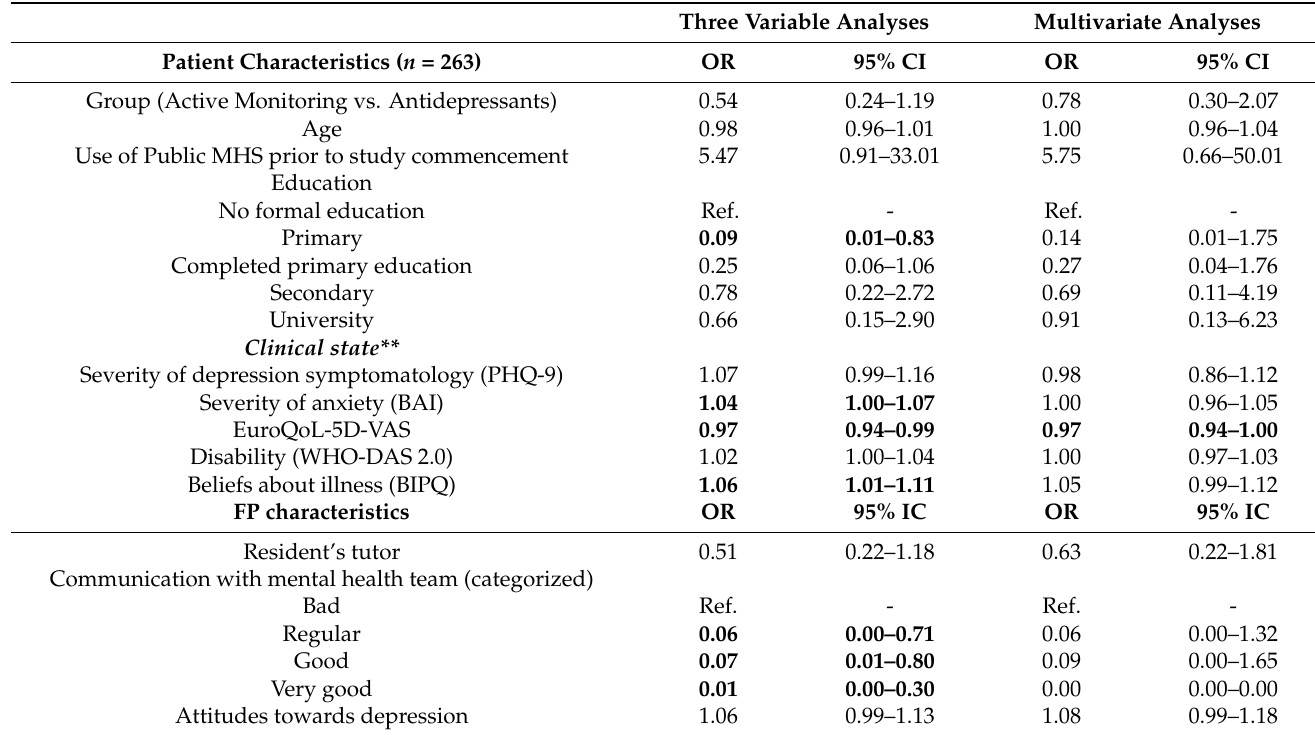
Table 3. Factors associated with use public Mental Health Services (MHS) based on three variable and multivariate imputed multilevel logistic regression models